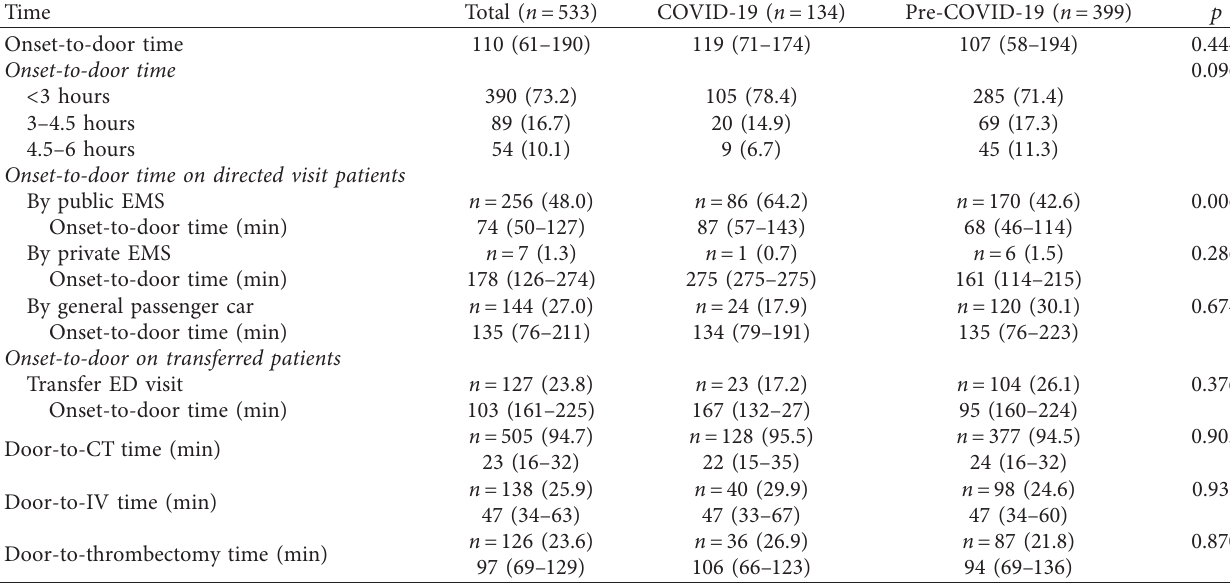
Table 2: The time spent on management from the symptom onset in patients with acute ischemic